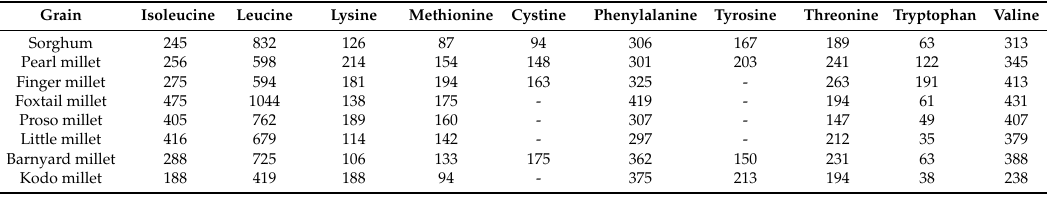
Table 4. Essential amino acid composition (mg/100 g) of different